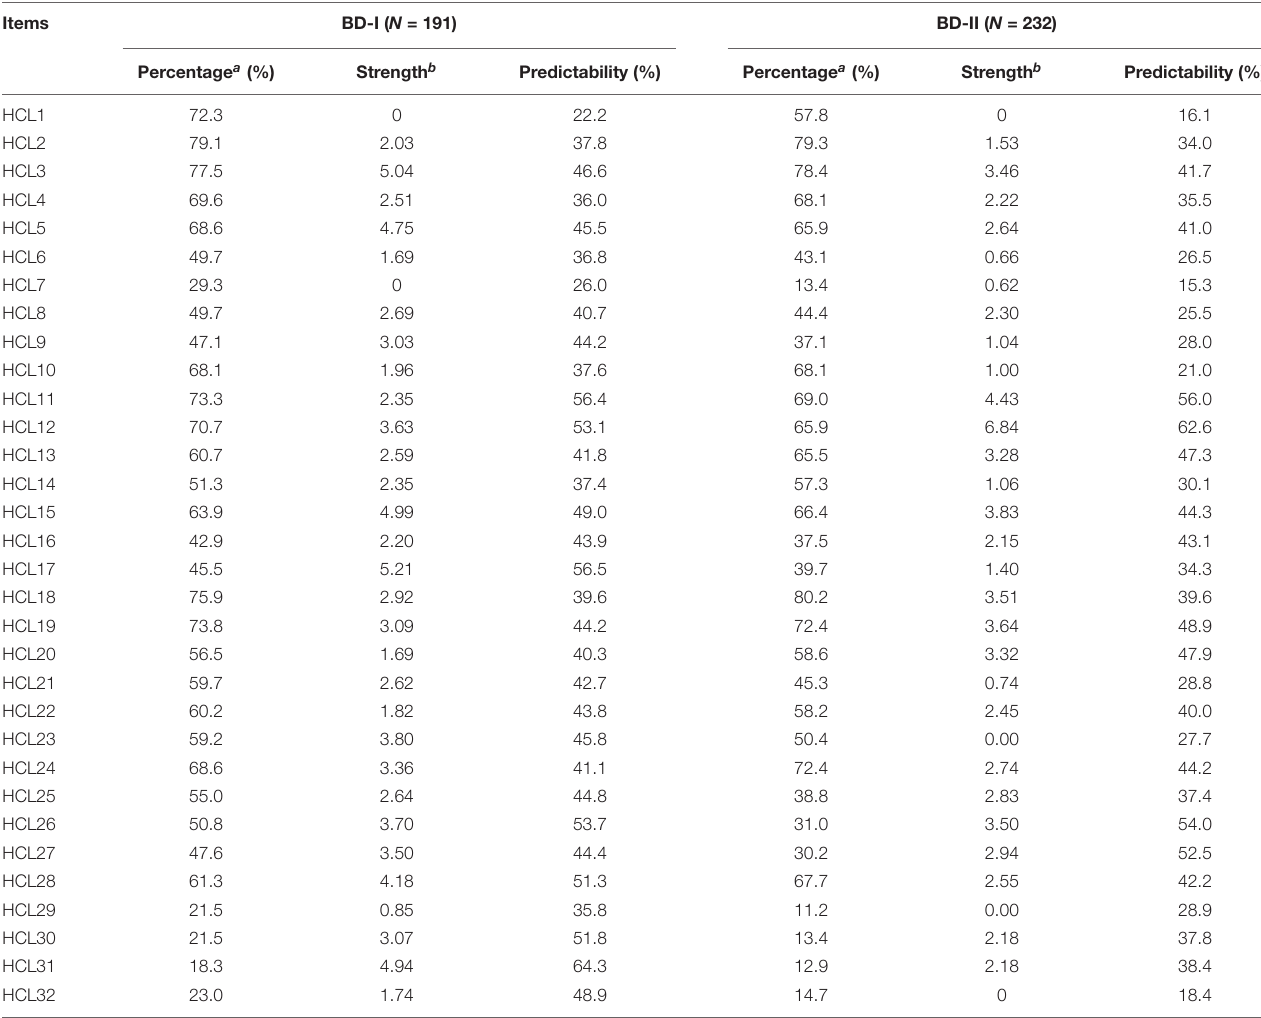
TABLE 1 | Descriptive statistics of HCL-32 items in patients with bipolar I/II